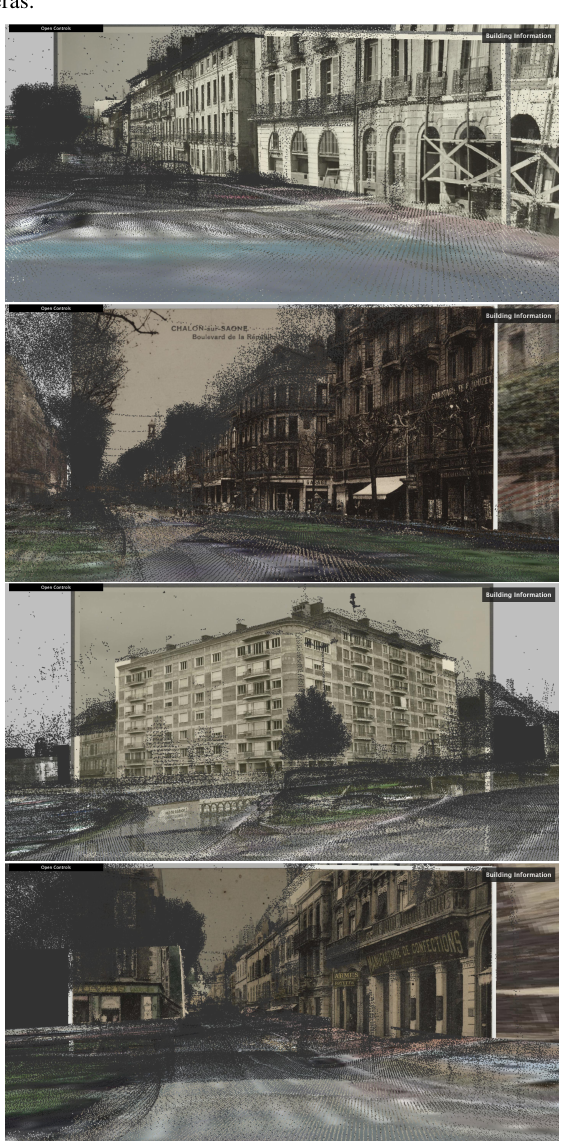
Figure 5. Focus and context configuration: In these 4 cases, the camera of the synthesized view is set to a zoomed-out version of one of the cameras that acquired a photograph of the dataset.